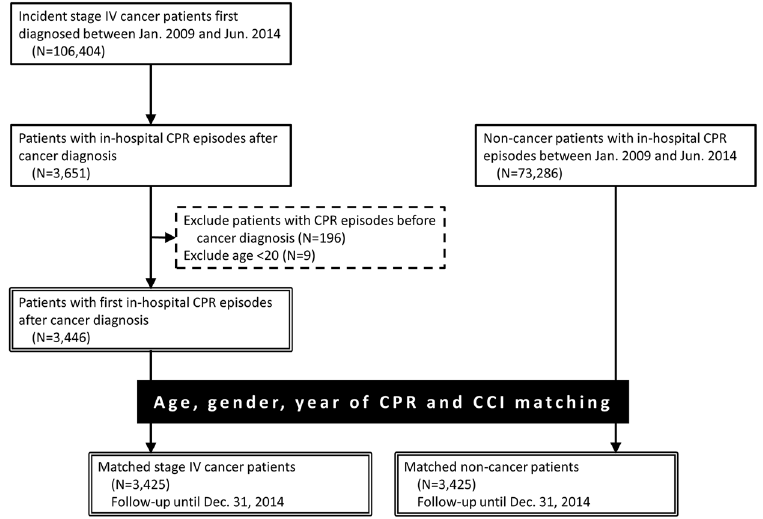
Figure 1. Flowchart of patient